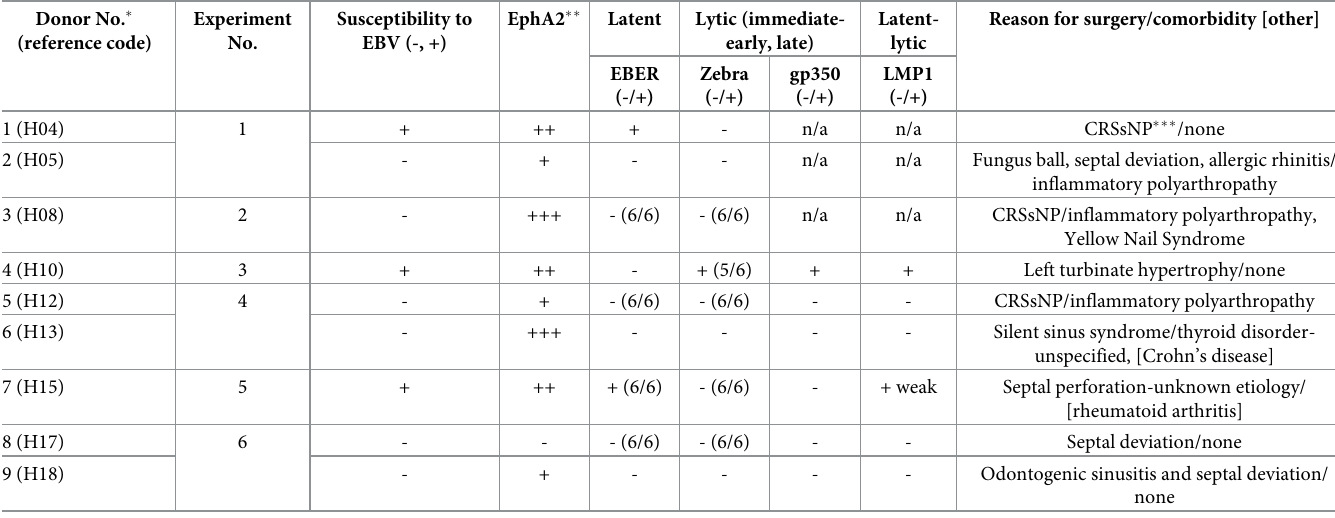
Table 1. Summary of molecular diagnostic results from EBV infection of pseudo-ALIs. Donor No. � Experiment (reference code)